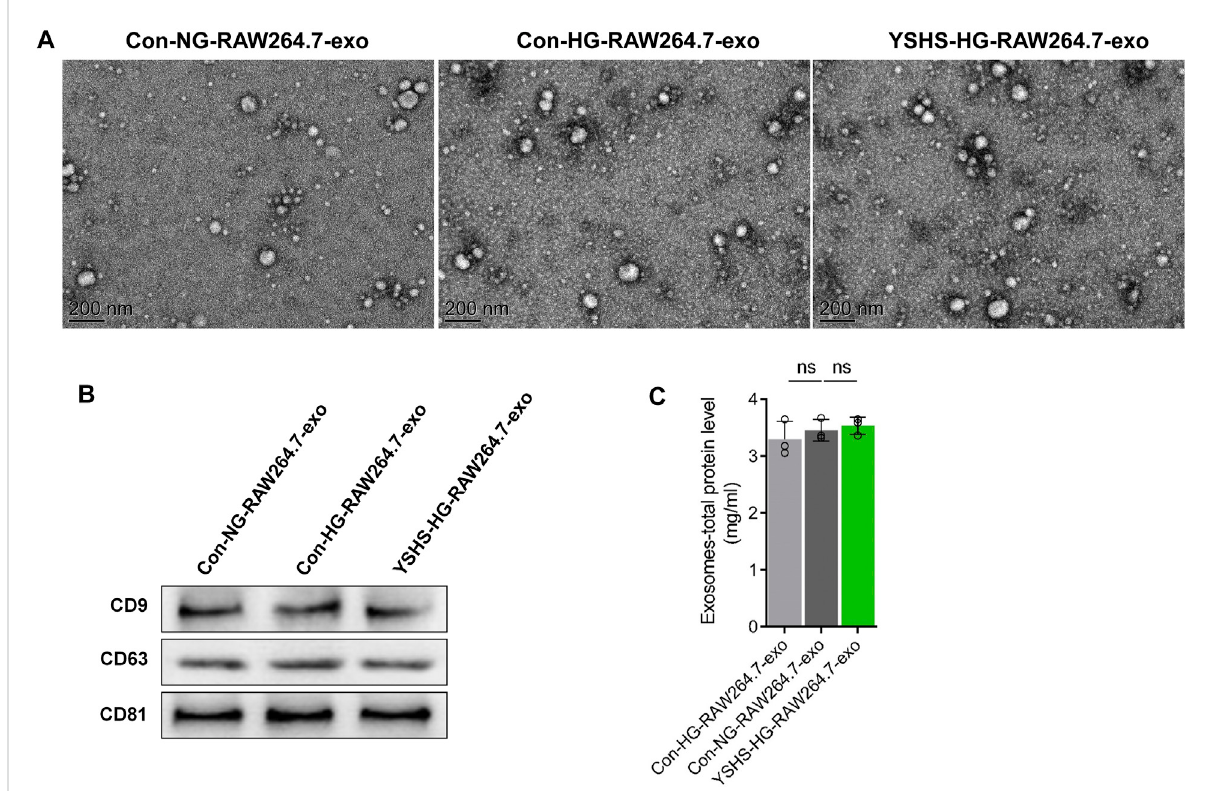
FIGURE 4 Identi fi cationofmacrophage exosomes andtheeffects ofYSHSand high-glucose stimulation onmacrophage-derived exosome secretion. (A) Images of macrophage-derived exosome morphology taken by transmission electron microscopy (TEM). (B) Measurement of the protein level of CD9,CD63,andCD81ofmacrophage-derivedexosomesbyWesternblotting. (C) Theproteinconcentrationofmacrophage-derivedexosomeswas detected by the BCA method. Data analysis adopts a one-way ANOVA analysis of variance. SD indicates error bars ns p > 0.05. NG indicates normal glucose (5.5 mM D -glucose), and HG indicates high glucose (30 mM D -glucose). Con-NG-RAW264.7-exo indicates exosomes